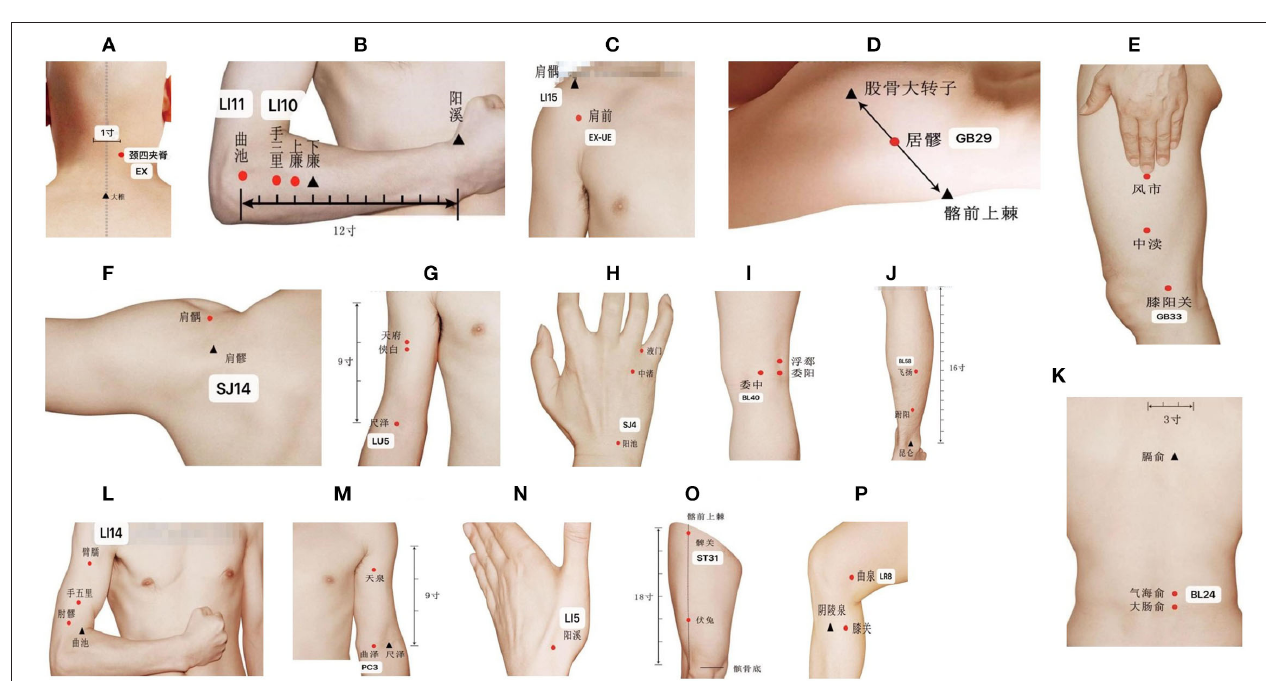
FIGURE 2 | Location of acupoints. (A) EX-B2; (B) LI10; (C) EX-UE & LI15; (D) GB29; (E) GB33; (F) SJ14; (G) LU5; (H) SJ4; (I) BL40; (J) BL58; (K) BL24; (L) LI14; (M) PC3; (N) LI5; (O) ST31; (P)